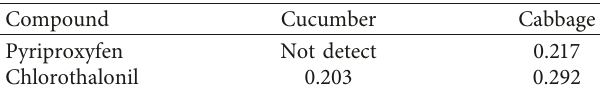
Table 6: The residues (mg · kg − 1 ) of pyriproxyfen and chlorothalonil in cucumber and